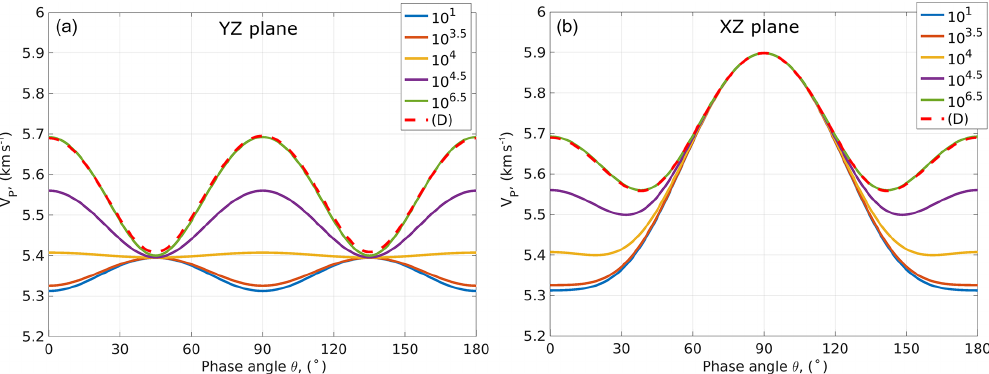
Figure 5. P-wave phase velocity versus phase angle in the Y – Z plane (a) and the X – Z plane (b) . Curves 10 1 –10 6 . 5 denote the frequency of the P wave for the model with connected cracks. (D) denotes the P wave for the model with disconnected cracks.